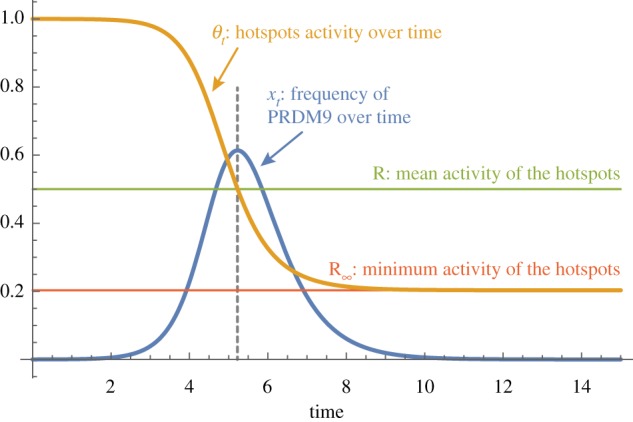
Trajectory of the frequency and the activity of a typical allele through time, under the deterministic and mean-field approximation (see text for details). (Online version in colour.)